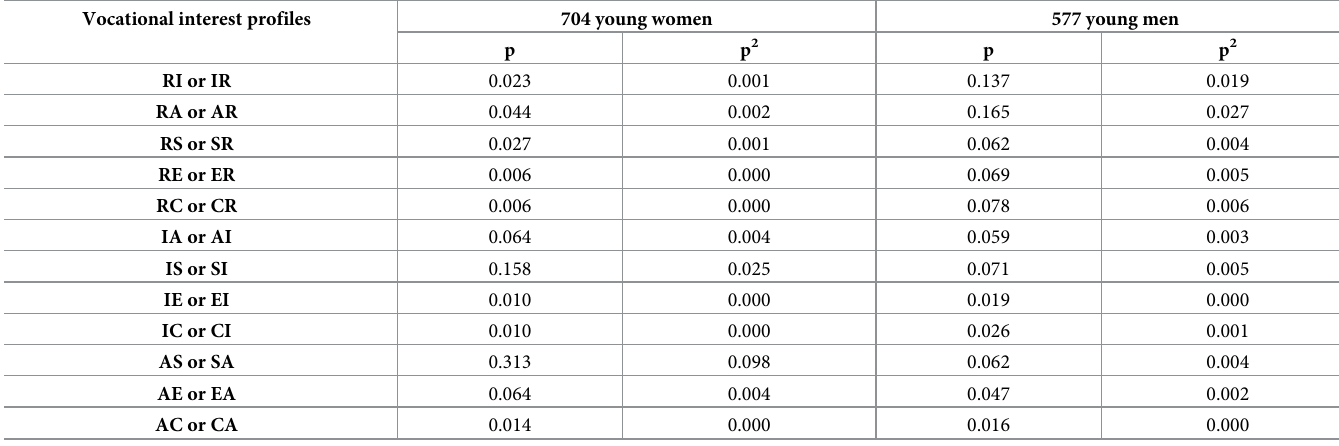
Table 8b. 15 two-dimensional interest